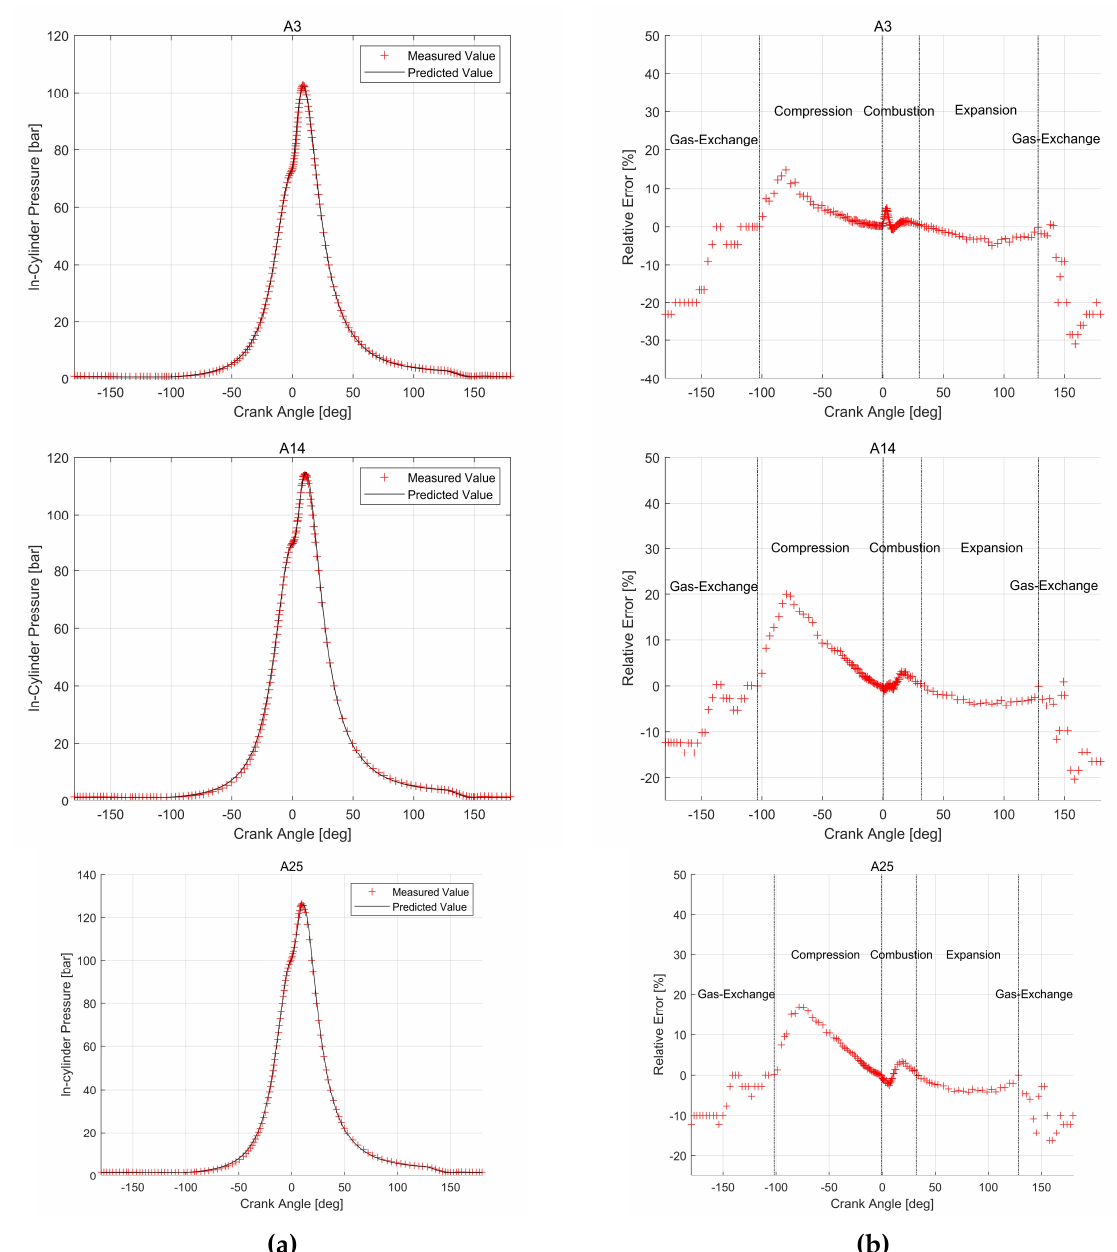
Figure 20. Prediction result and error distribution of the cylinder pressure analytic model: ( a ) predictive results; ( b ) error distribution.